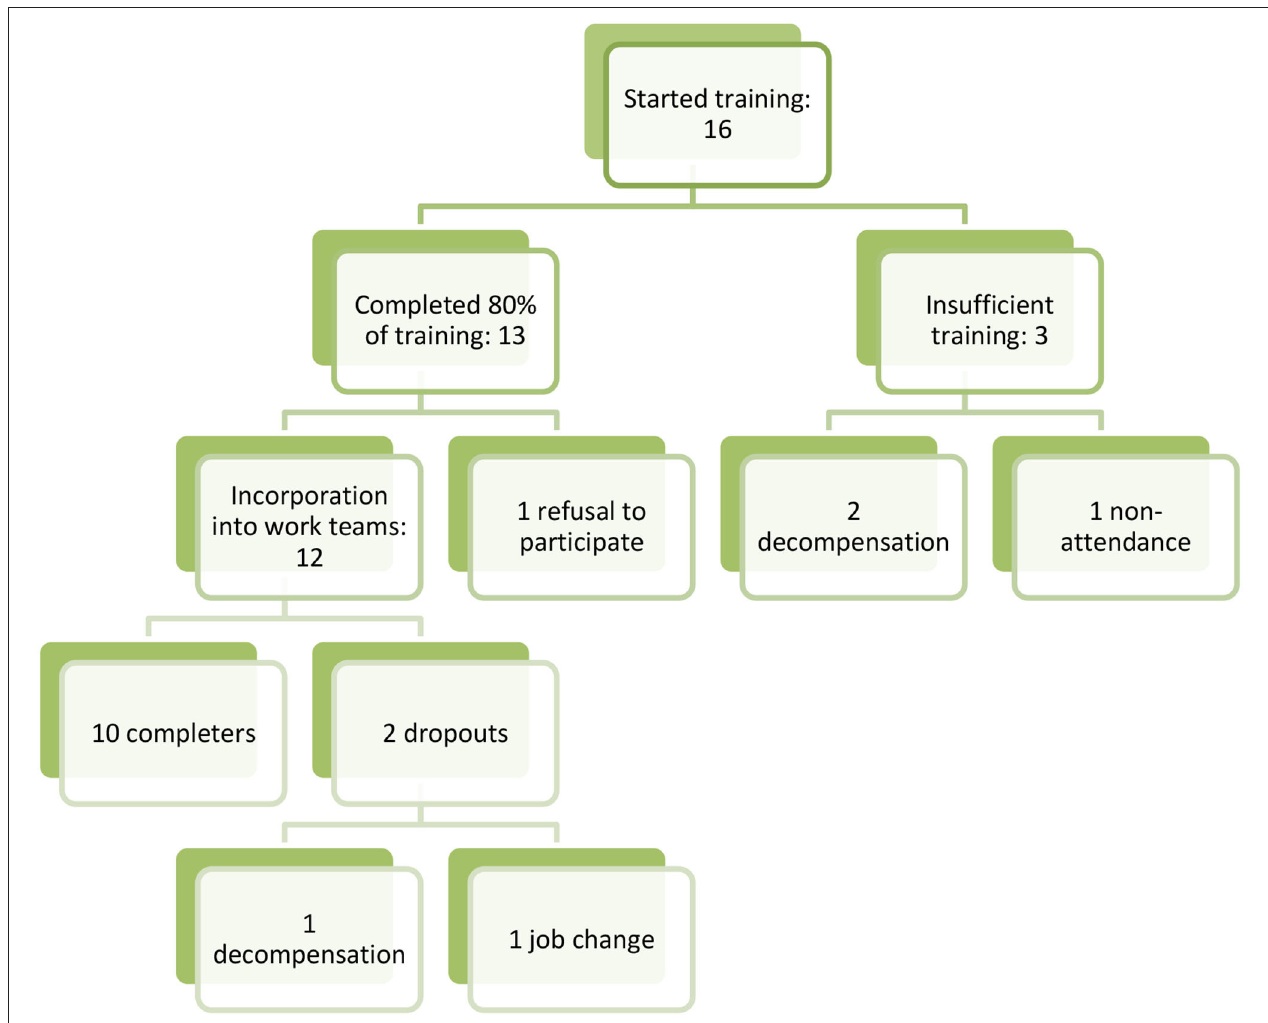
FIGURE 1 | Peer-to-peer insertion